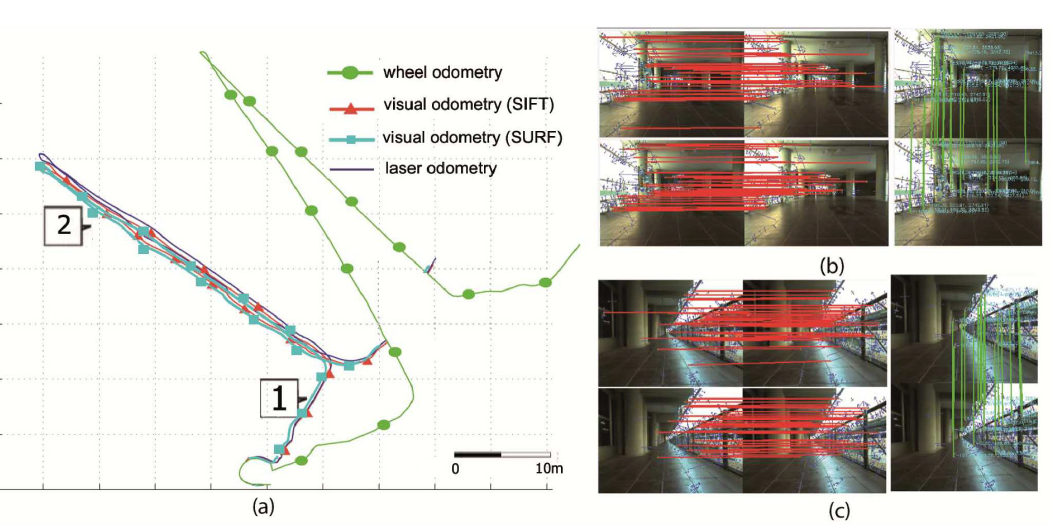
Figure 14. (a) Trajectories estimated by visual and wheel odometry (black, red, cyan and green line, respectively) for the third test (outdoor scenario). Blue lines define the trajectory estimated by the laser scan matching; and (b) , (c) two captures from the stereo camera and the results of the both matching